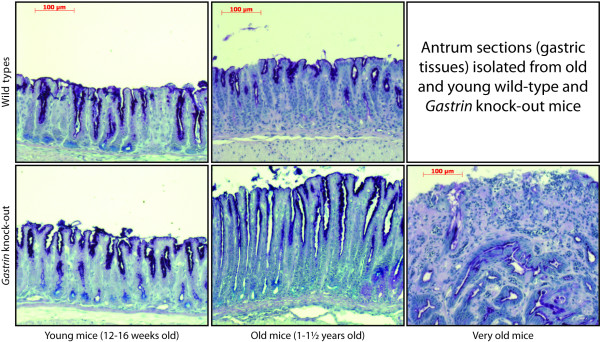
Old Gastrin knockout mice develop gastric adenomas. Antrum sections isolated from 12-16 weeks old mice (left panel), 12 to 18 months old mice (middle panel) and older than 18 months mice (right panel), from wild type (upper panel) and Gastrin knockout mice (lower panel). Sections show adenoma development in antrum tissues in the Gastrin knockouts compared to the wild types.